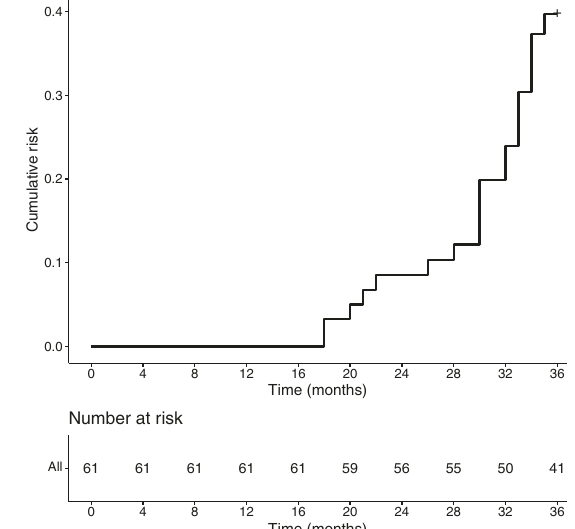
Fig. 1 Kaplan – Meier estimates showing cumulative risk of dyskine- sia in PD patients.